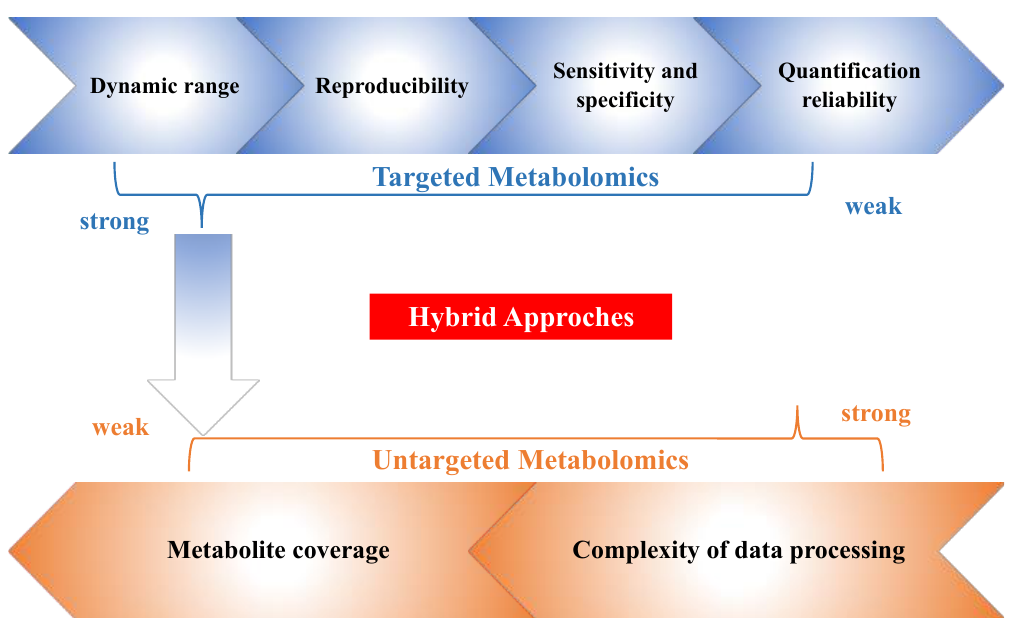
Figure 3. Considerations for novel metabolomics analysis with hybrid approaches with advantages from both untargeted and targeted analysis.